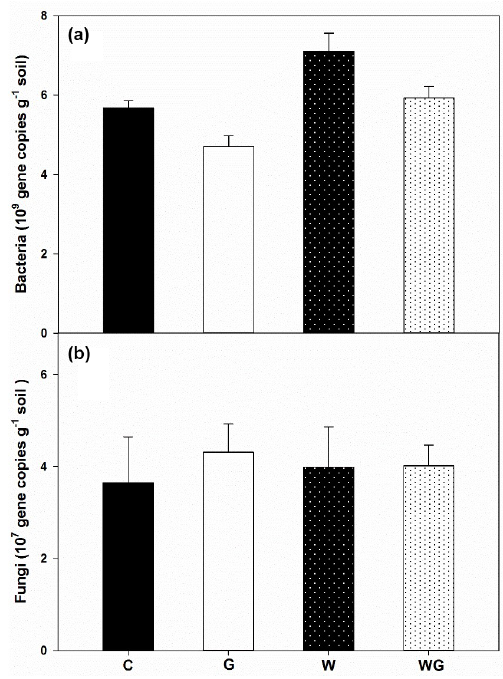
Figure 3. Abundance of bacteria (a) and fungi (b) in an alpine meadow; C (black bar), control treatment; G (white bar), winter grazing treatment; W (white-dotted bar), warming treatment; WG (black-dotted bar), warming combined with the winter grazing treat- ment. Values are means ± 1s.e.m. ( n =